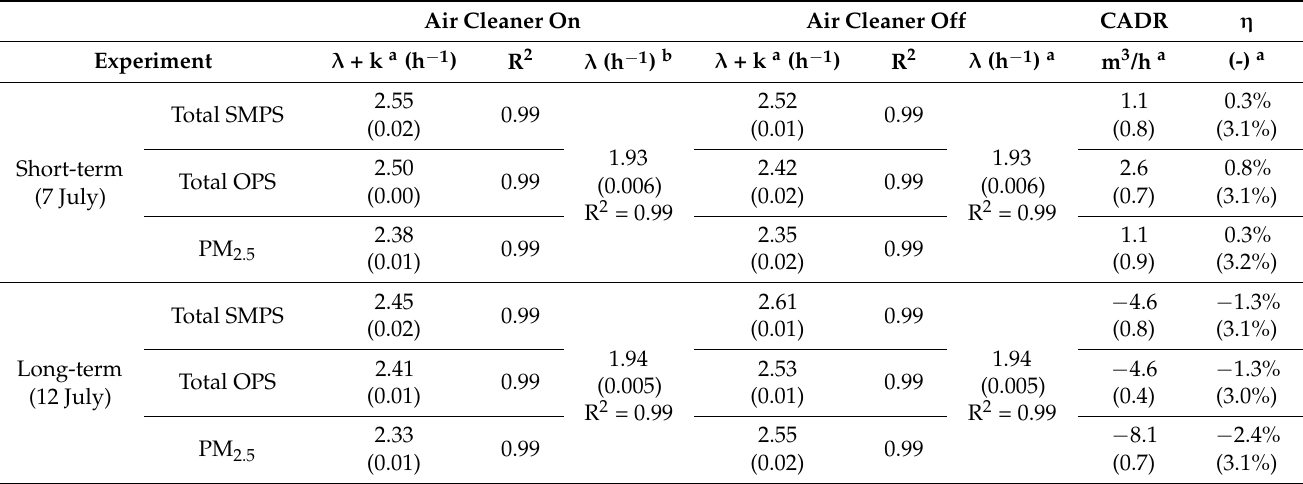
Figure 10. First-order particle loss rate constants ( λ + k ) from a long-term perturbation test (12 July 2021) after the air cleaner operated for 24+ hours and after the air cleaner was switched off: ( a ) total number concentrations measured by the SMPS (0.01–0.4 µm), ( b ) total number concentrations measured by the OPS (0.3–10 µm), and ( c ) estimated PM 2.5 mass concentrations. Table 4. Summary of first-order loss rate constants and estimated single-pass removal efficiencies of the EAC resulting from short-term (7 July 2021) and long-term (12 July 2021) chamber perturbation tests targeting only particle injection and